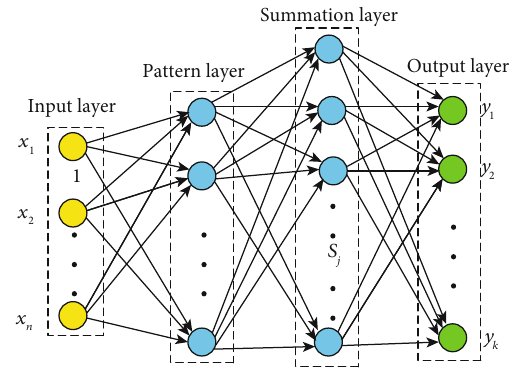
Figure 5: Schematic of generalized regression network [28].